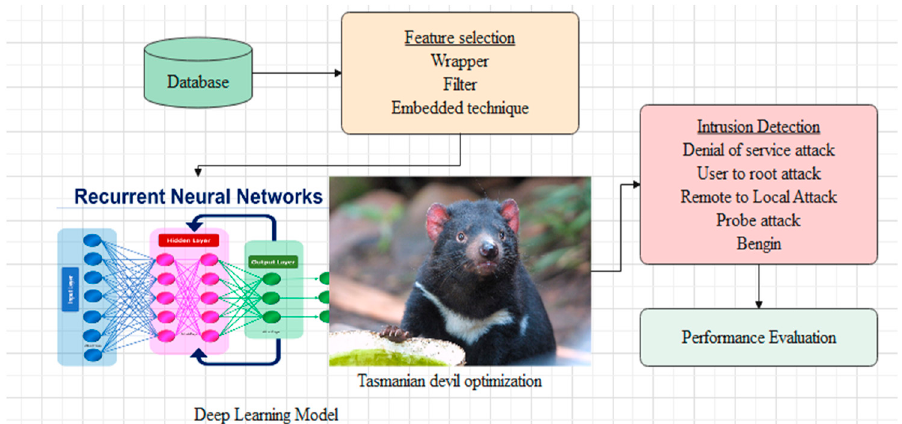
Figure 2. Design of intrusion detection.